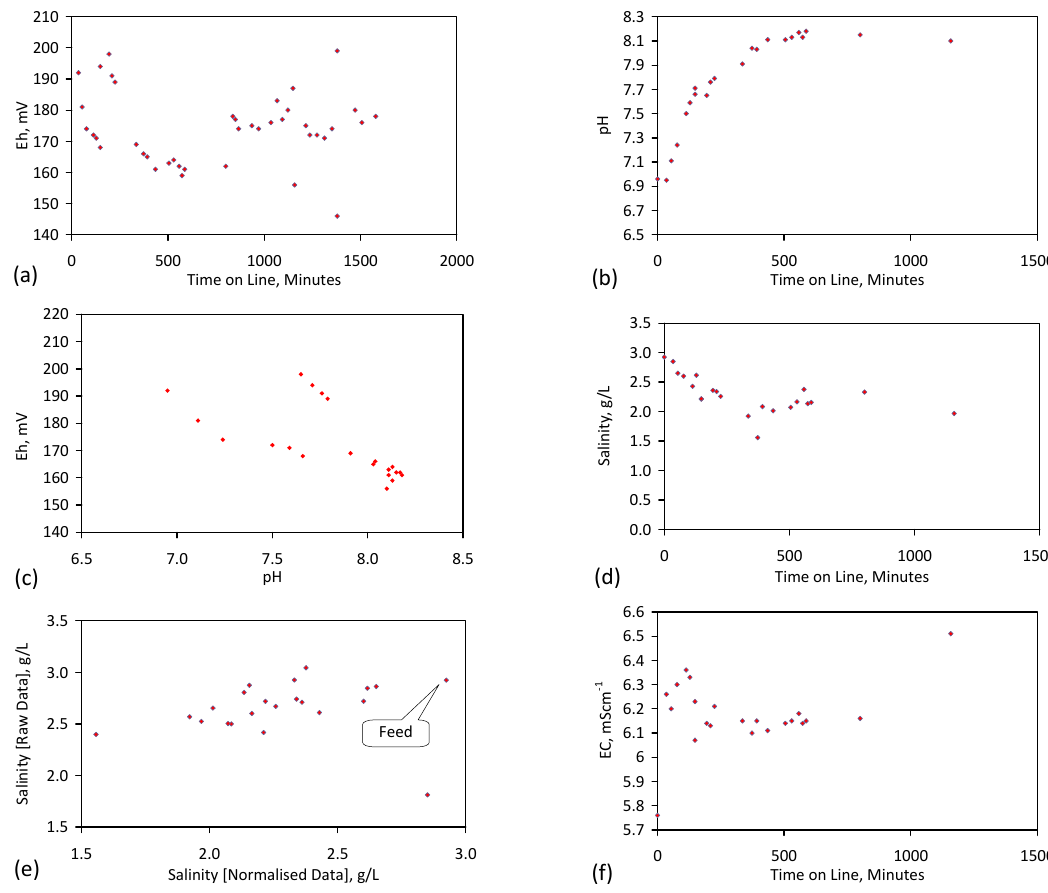
Figure C23. ZVM TPA example Trial E146. 3rd Reuse; Operating Temperature: 15–21 C; Oxidising Environment: Water volume in the reactor = 0.24 m 3 ; ZVM TPA from Trial E145 in a cartridge = 0.4 kg; Air flow = 120 L·h − 1 . ( a ) Eh vs. time; ( b ) pH vs. time; ( c ) pH vs. Eh; ( d ) Salinity vs. time; ( e ) Salinity calculated from normalised data vs. salinity calculated from raw data; ( f ) EC vs. time.